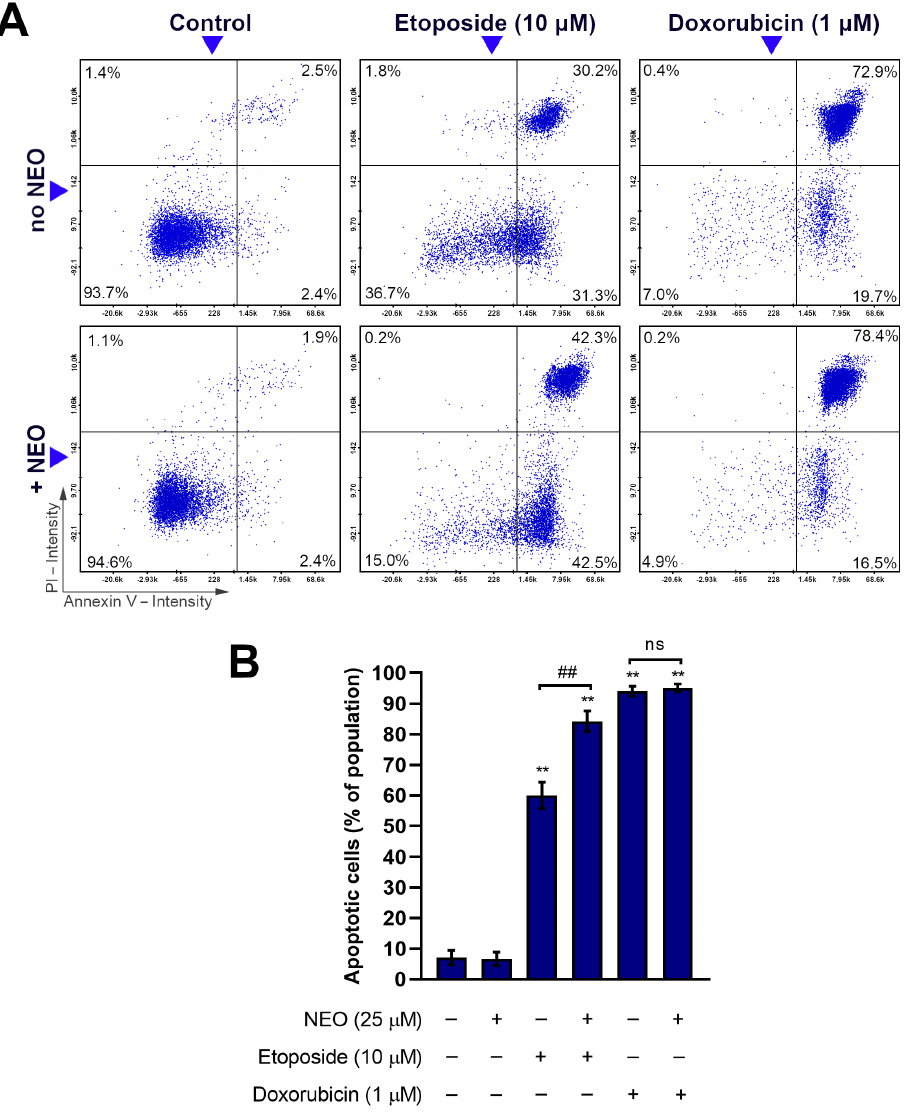
Figure 4. The detection of apoptotic subpopulation by Annexin V assay in SW1783 cells treated for 48 h with doxorubicin (1 μM) or etoposide (10 μM) alone and their mixes with NEO (25 μM). ( A ) Scatter plots showing cell population divided into four quadrants: lower left—healthy cells (Annexin V-negative/PI-negative), lower right—early apoptotic cells (Annexin V-positive/PI-negative), upper right—late apoptotic cells (Annexin V-positive/PI-positive), and upper left—non-apoptotic dead cells (Annexin V-negative/PI-positive). ( B ) Mean values ± SD of the percentage of apoptotic cells (Annexin V-positive) from three independent experiments are displayed in the bar graph. ** p < 0.001 vs. control; ## p < 0.001 for comparisons between groups; ns—non-significant difference.